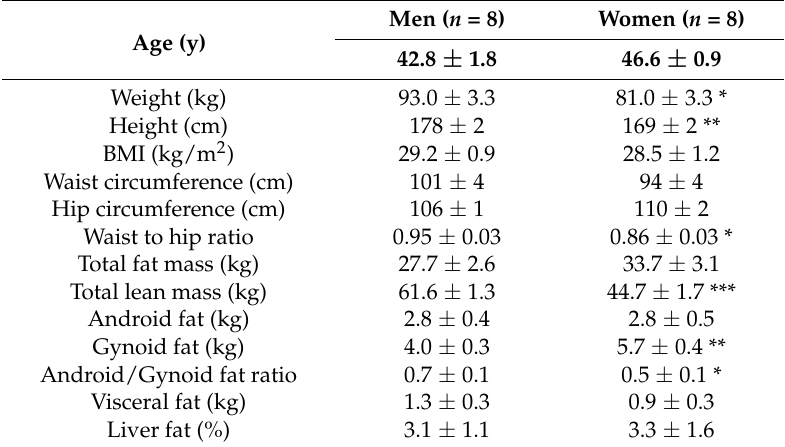
Table 1. Participant